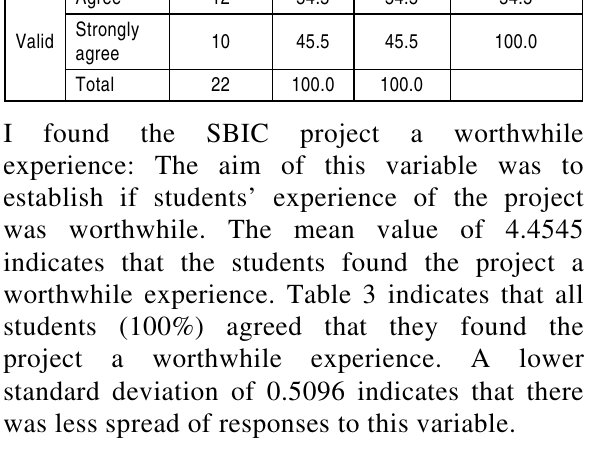
Table 3. Students’ experience of the SBIC